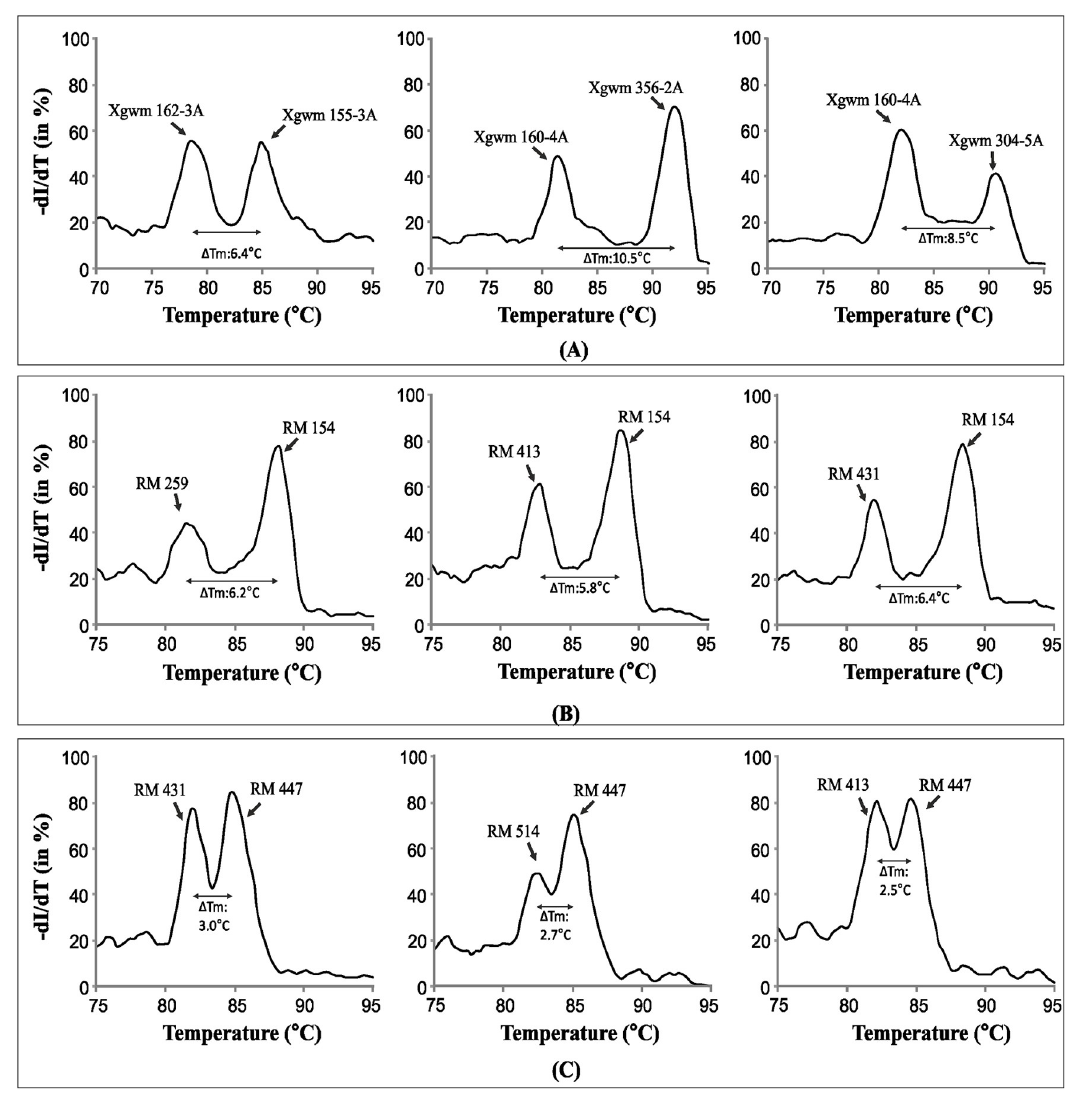
Fig 6. Multiplex STMS analysis. SYBR Green melt-profiles generated in multiplex PCR of STMS marker pairs in wheat and rice: A) multiplex analysis of three pair of wheat STMS markers with Δ Tm > 5 ˚C, B) multiplex analysis of three pair of rice STMS markers with Δ Tm > 5 ˚C, C) multiplex analysis of three pair of rice STMS markers with Δ Tm < 5 ˚C. Δ Tm is ‘melting temperature difference’. Designation of STMS used in multiplex assays are shown in each melt-profile plot and arrows indicate the STMS specific